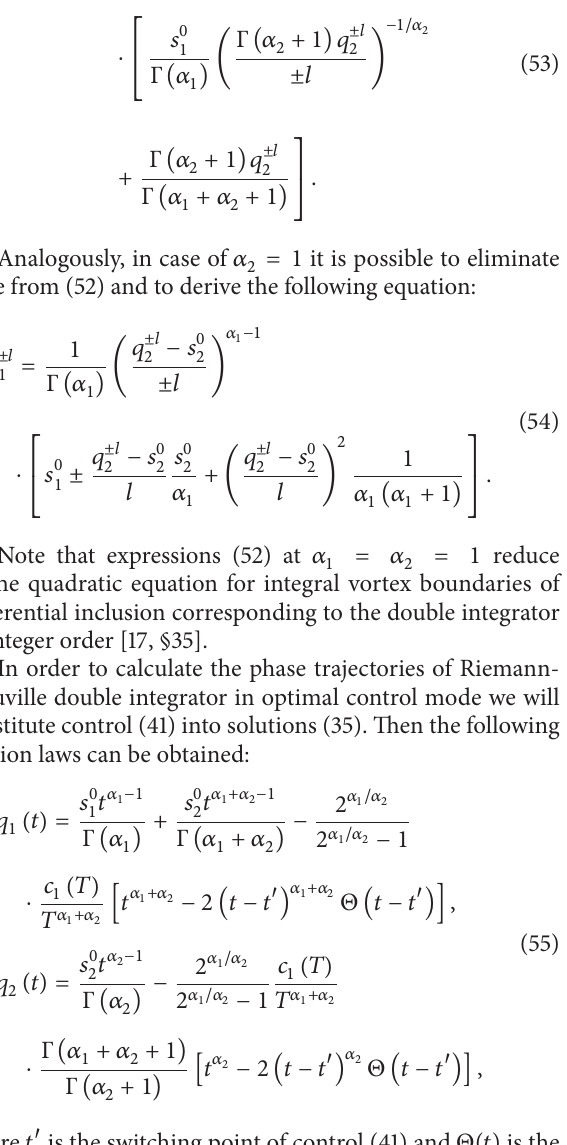
𝑞 0 = 1 (for Caputo integrator). The solid lines correspond to 𝑝 󸀠 = 1 , the dotted lines correspond to 𝑝 󸀠 = 3/2 , and the dash-dotted lines correspond to 𝑝 󸀠 = 2 . It is clear that all of these curves decrease monotonically which correspond to